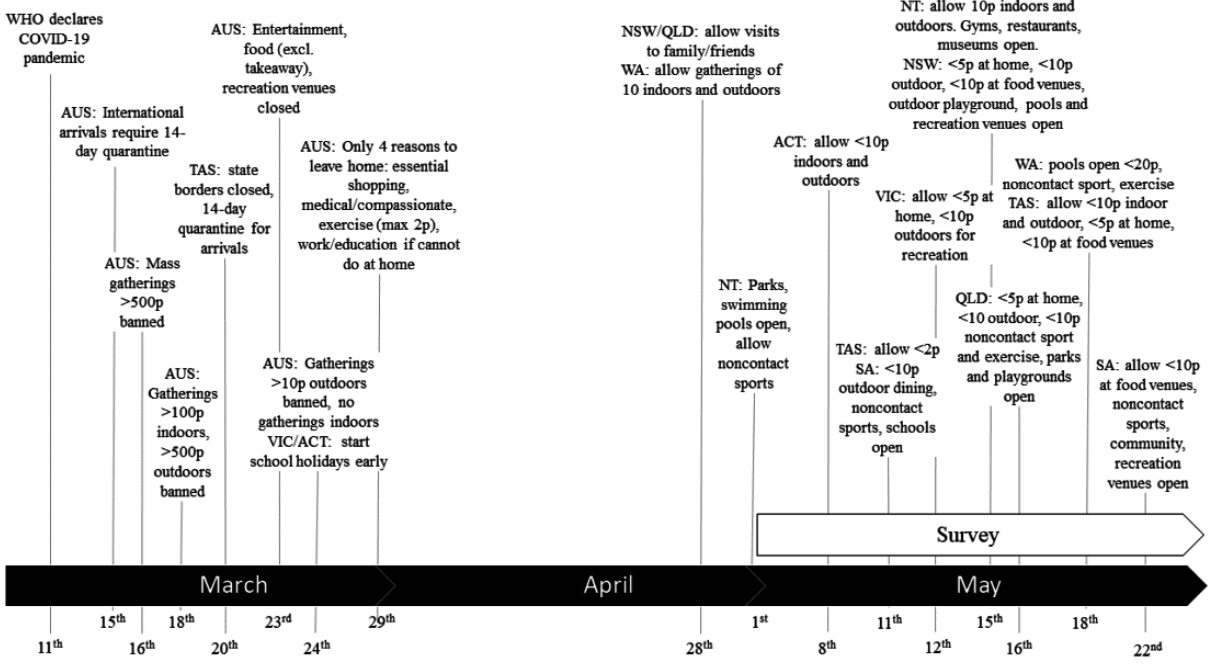
Figure 1. Australian federal- and state-imposed restrictions to stop the spread of COVID-19. ACT: Australian Capital Territory; AUS: Australia; NSW: New South Wales; NT: Northern Territory; p: people; QLD: Queensland; SA: South Australia; TAS: Tasmania; VIC: Victoria; WA: Western Australia; WHO: World Health